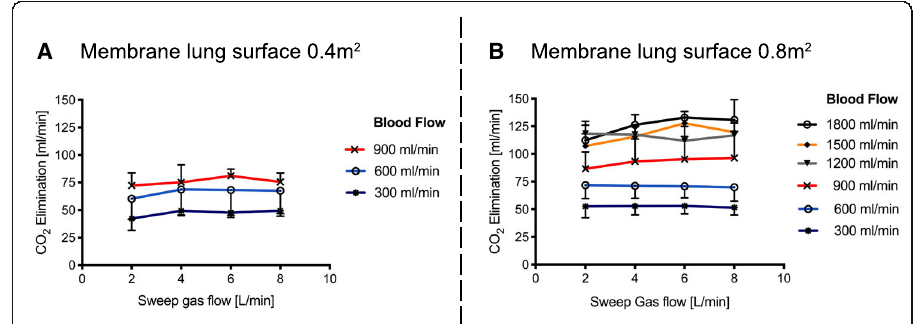
Fig. 3 Extracorporeal elimination of carbon dioxide (CO 2 ) depending on blood flow and sweep gas flow with a membrane lung surface of 0.4m 2 ( a ) and 0.8m 2 ( b ). The extracorporeal CO 2 elimination was plotted against sweep gas flow. Blood flow was titrated from 300 to 900 mL/min ( a ) and 300 to 1800 mL/min ( b ). Each data point represents the mean and standard deviation among nine pigs. Of note, compared to Fig. 1, the values shown are the absolute and non-normalized CO 2 values, demonstrating the physiological variance of the CO 2 amount before the membrane lung in an animal ECCO 2 R experiment